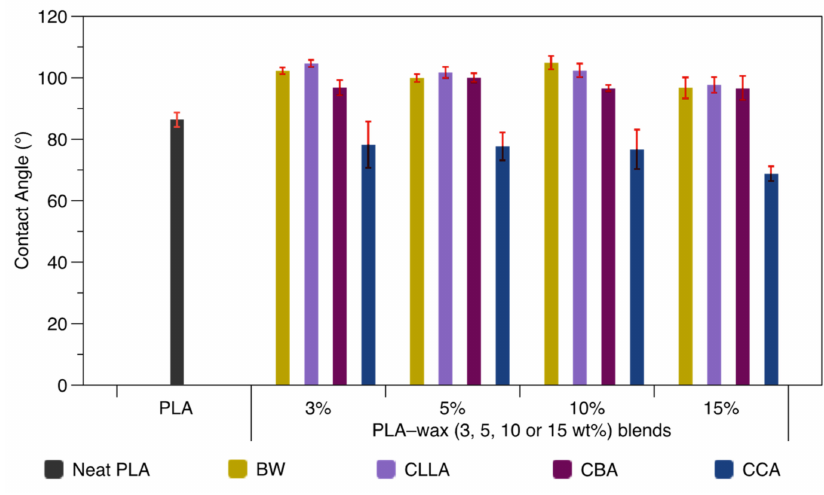
Figure 7. Contact angle values for neat PLA and PLA–wax blends at different